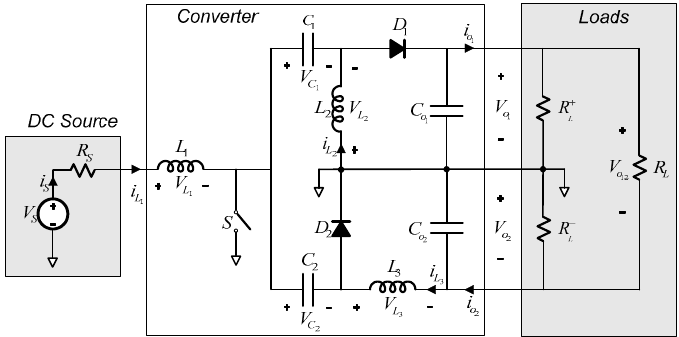
Figure 3. SEPIC (single-ended primary-inductor converter)- Ć uk combination converter.